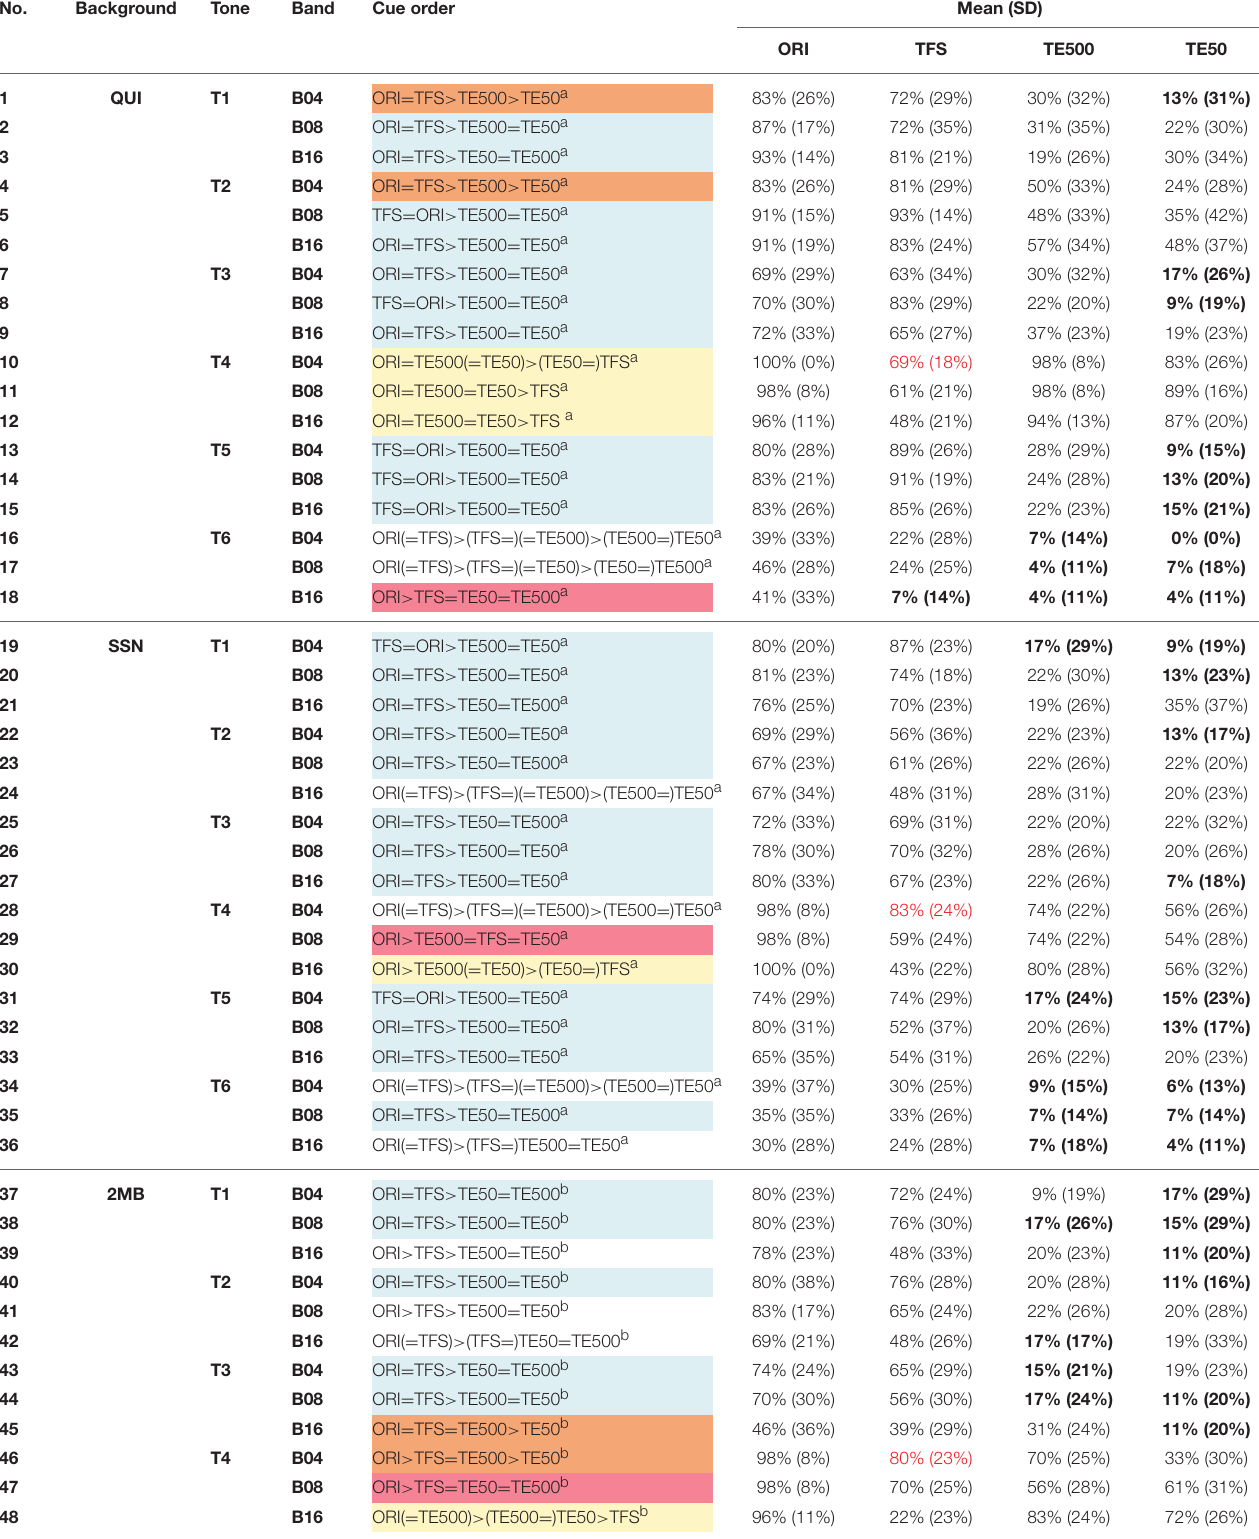
TABLE 8 | Results of pairwise comparisons in Tones * Bands * Cue three-way repeated measures ANOVA on tone accuracy.